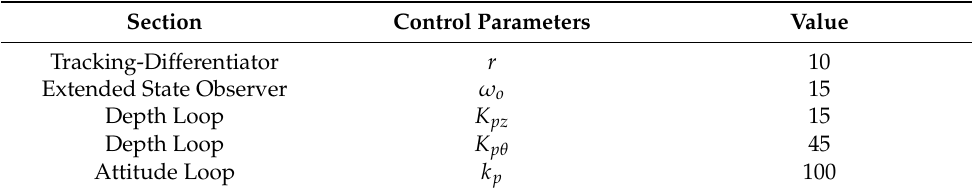
Table 2. Control